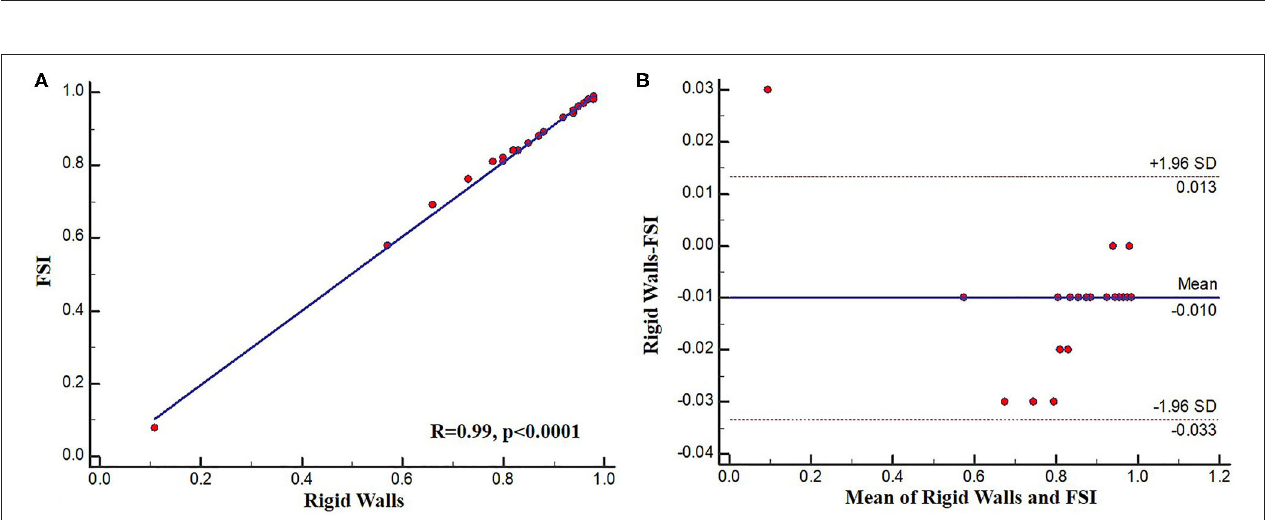
FIGURE 7 | (A) Regression plot and (B) Bland-Altman plot comparing FSI and rigid wall SmartFFR calculations.